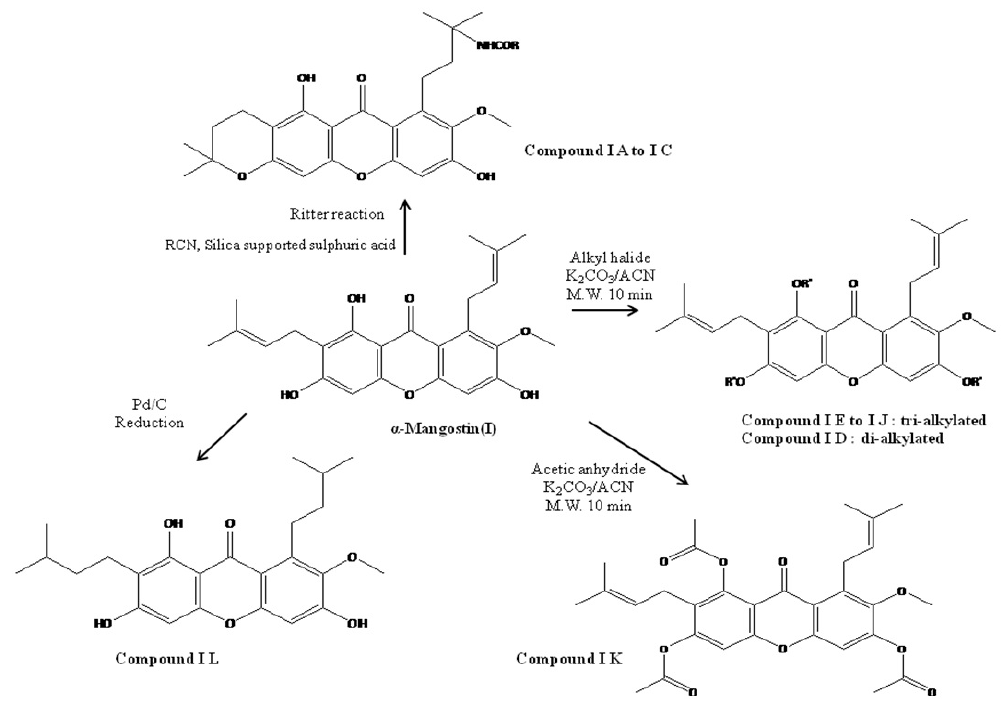
Figure 2. Reaction scheme leading to different derivatives.